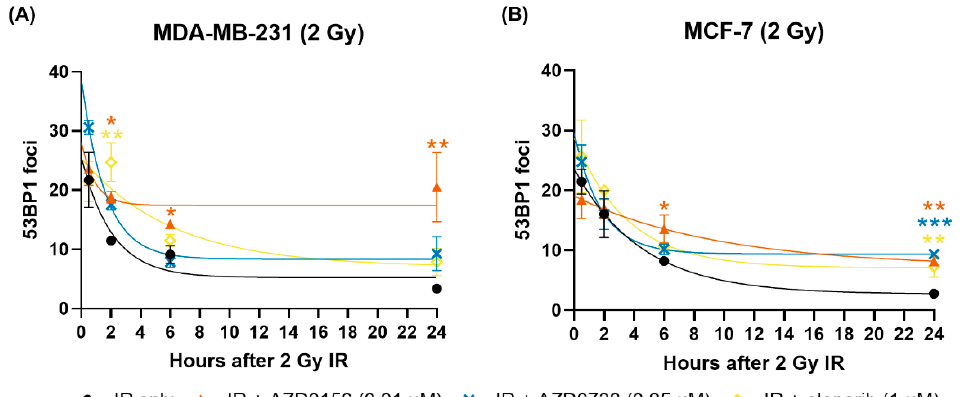
Figure 9. DDR inhibitors delay the resolution of 53BP1 foci in irradiated cells. Immunofluorescence experiments were conducted to assess DNA DSB repair kinetics in irradiated ( A ) MDA-MB-231 and ( B ) MCF-7 cells, using 53BP1 foci as DSB markers. Cells were drugged one hour before irradiation.